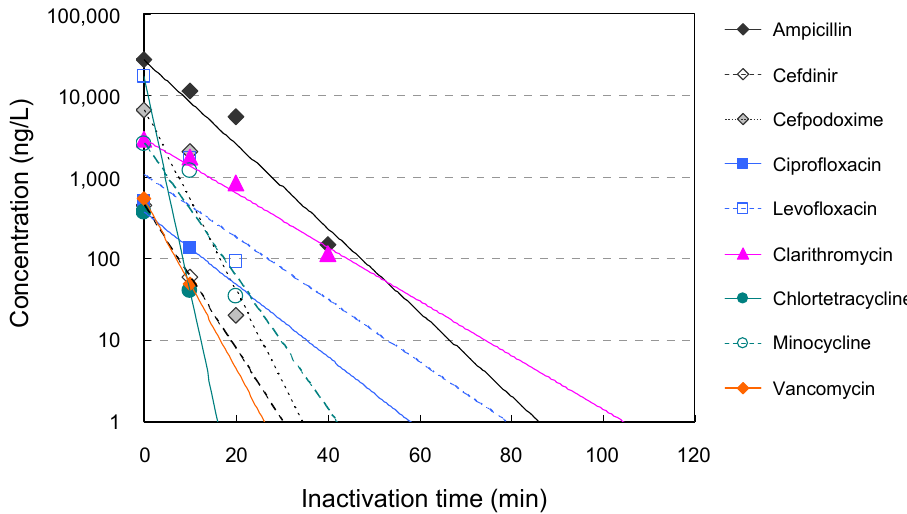
Figure 3. Time course of the concentration of antimicrobials in hospital wastewater during ozone treatment. Removal of antimicrobials over time during ozone treatment of hospital wastewater. The vertical axis shows the logarithmic value of the detected concentration, and the horizontal axis shows the time after the start of treatment.